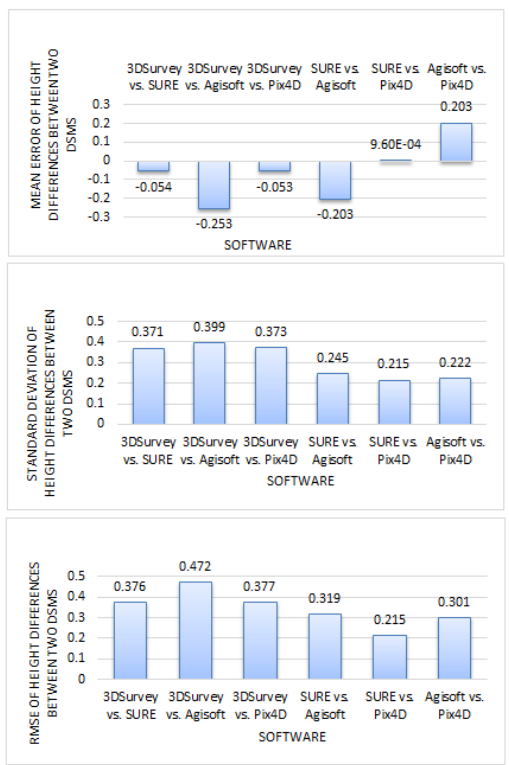
Figure 9. Standard measures [m] for accuracy assessment of two DSMs: the mean error (up), SD (middle), RMSE